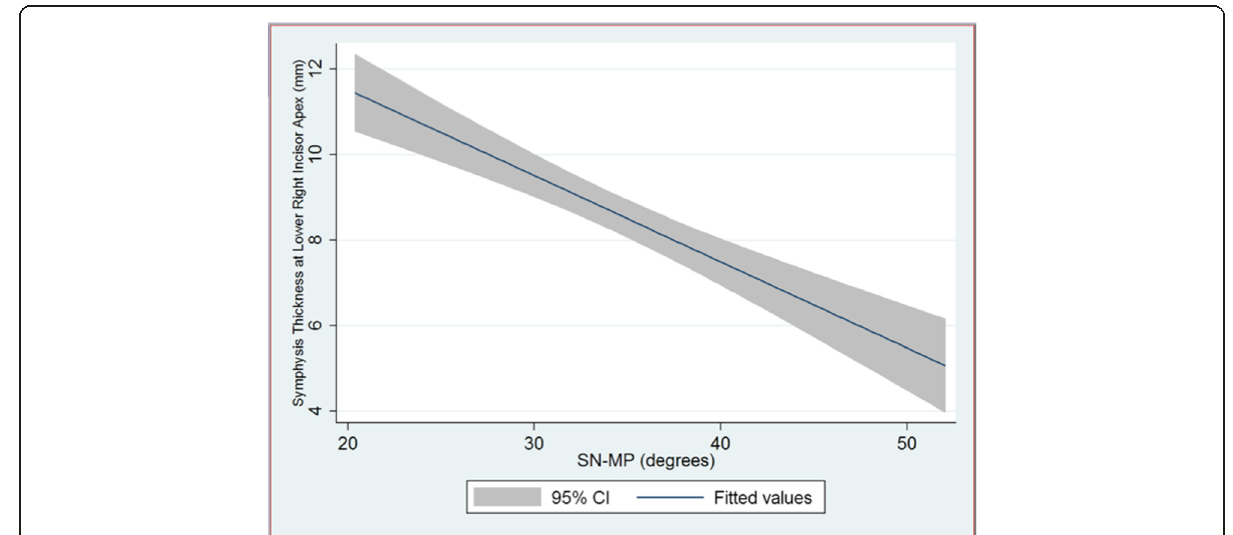
Fig. 4 Symphysis thickness at the lower right incisor apex versus SN-MP with 95 % confidence